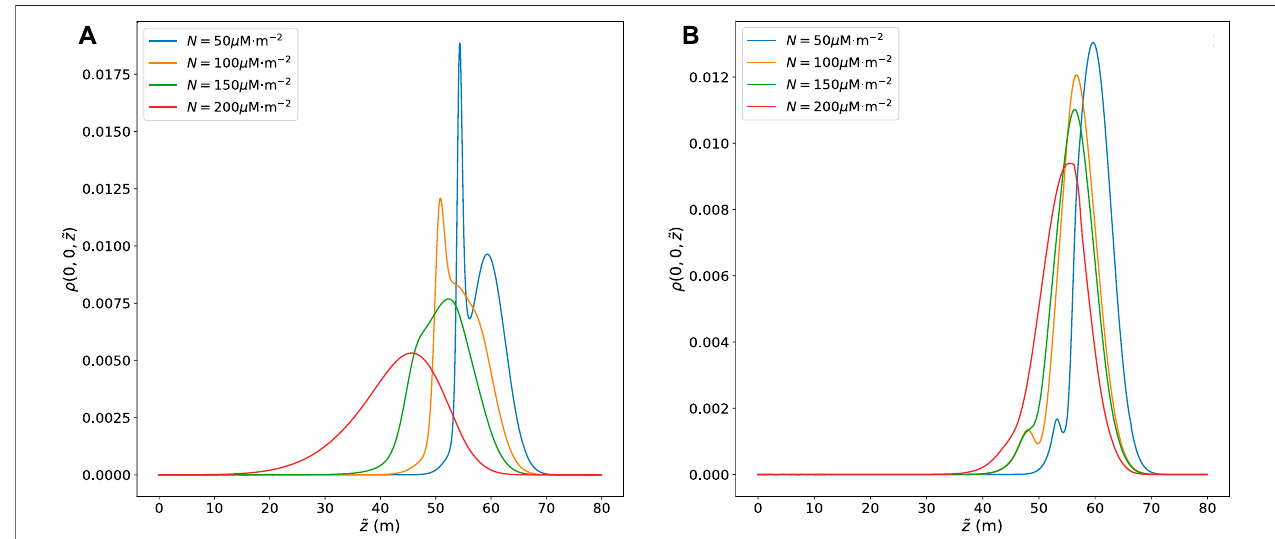
FIGURE 5 | The combined effects of the surface concentration of impurities and nutrients. The probability density function along the ~ z -axis, at ~ x (cid:2) ~ y (cid:2) 0 and at ~ t (cid:2) 300years, for (A) attractive ( β − 10 m 2 M − 1 s − 1 ) and (B) repulsive ( β − 10 − 10 m 2 M − 1 s − 1 ) chemotaxis, for different surface concentration of impurities N , D = 10 D = computed from Eqs 32 , 33 using a fi nite difference method. The particle radius is R = 10 − 6 m, the temperature gradient is | ∇ T | = 0.1K m − 1 and the active diffusivity is ~ D (cid:2) 100 ~ D . The nutrient source is centered at ~ z = 55 a